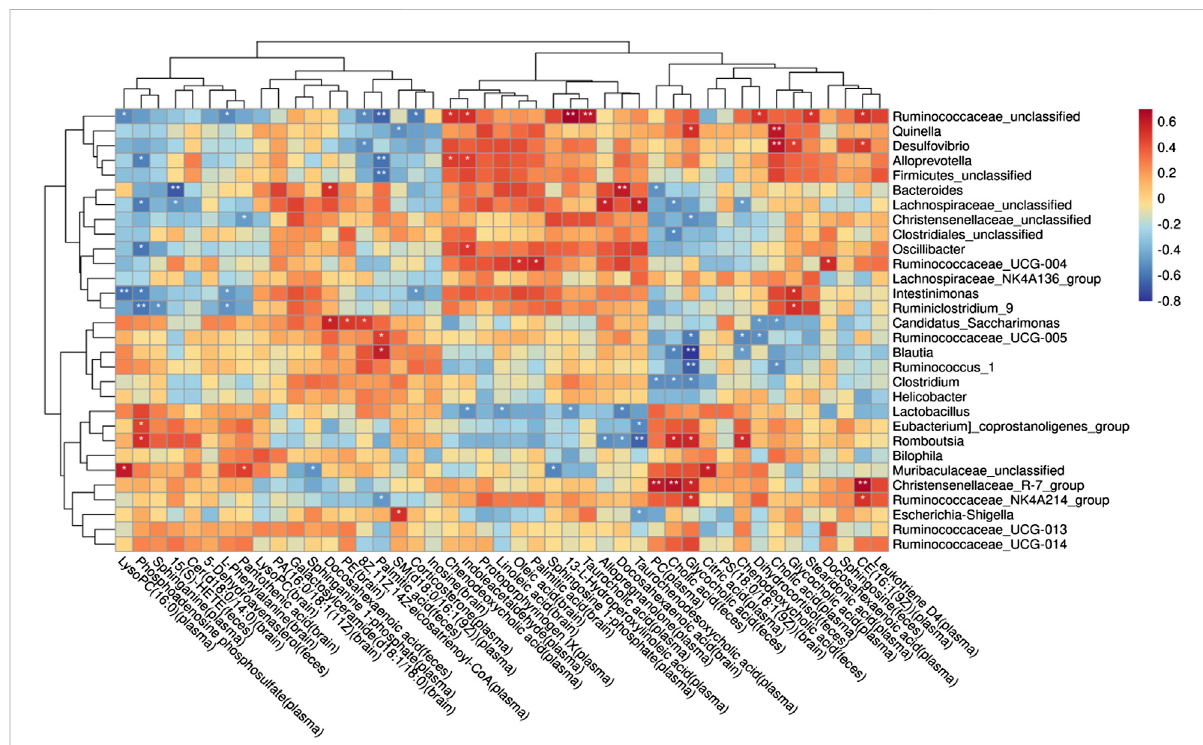
FIGURE 11 Potential relationship between metabolites and gut microbiota in rats with AD after schisandrin